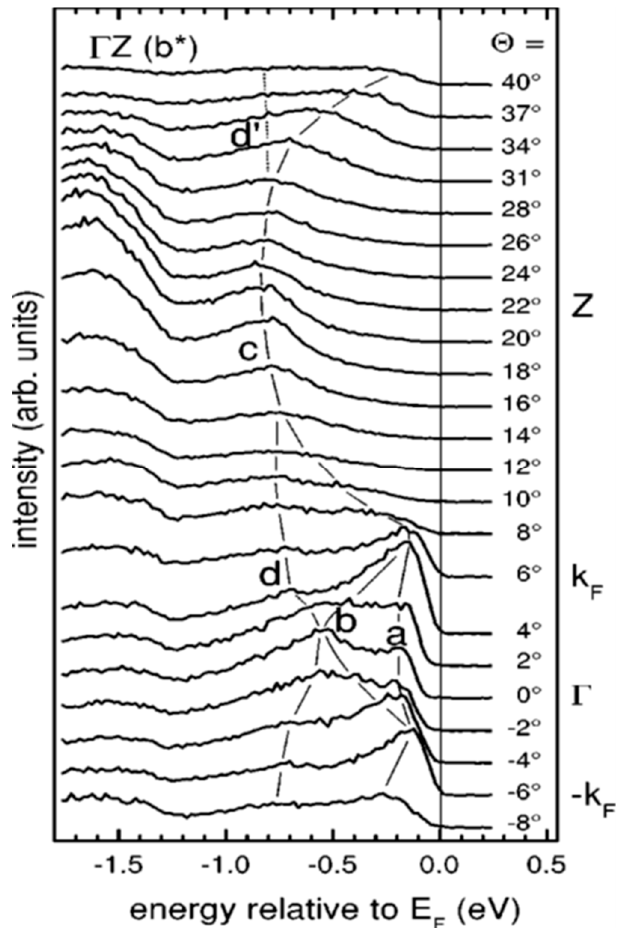
Figure 4. ARPES spectra of TTF-TCNQ measured along the Γ Z direction (h ν = 25 eV, T = 61 K). The thin lines are guides to the eye and are meant to indicate the dispersion of the spectral features. From Ref. [47] with permission.